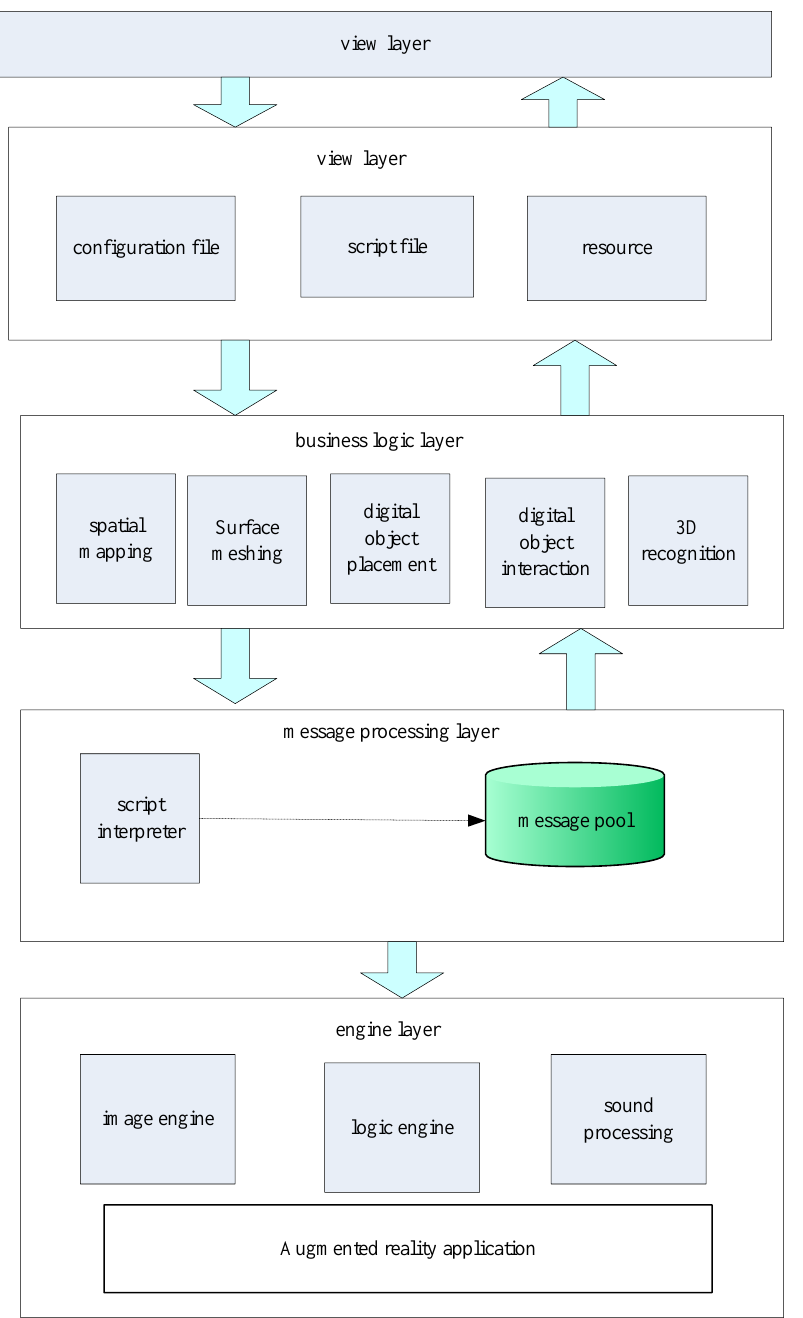
Figure 6. System Design Architecture.